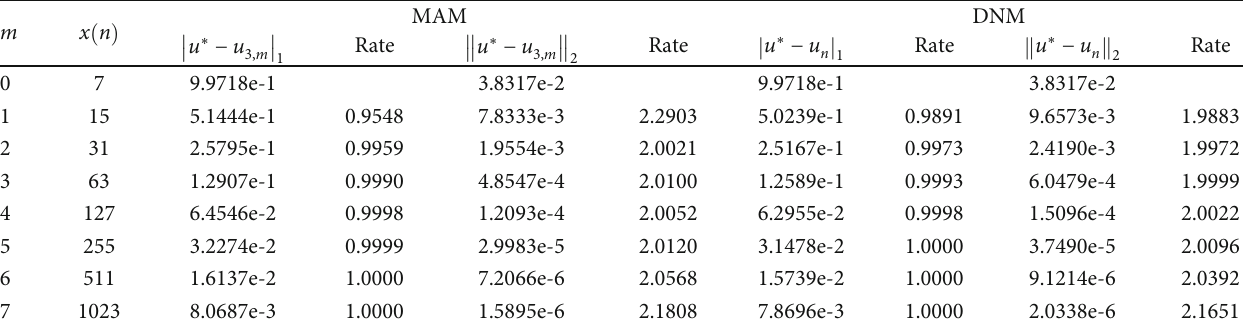
Table 6: Errors and convergent orders of MAM and DNM via linear basis in spatial direction with k = 3, τ = 0 : 005 , and α = 0 : 25 for Example